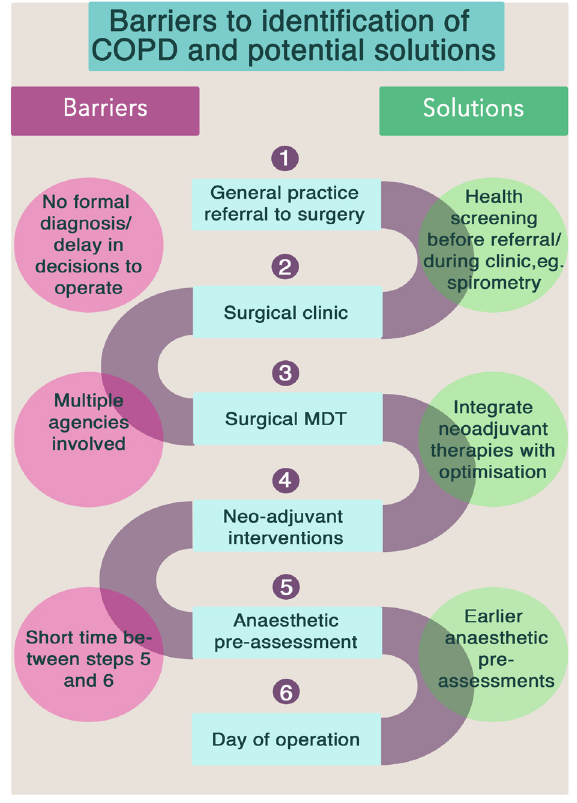
Figure 3. A summary of the challenges to identification (and thus treatment) of COPD for surgical patients and potential